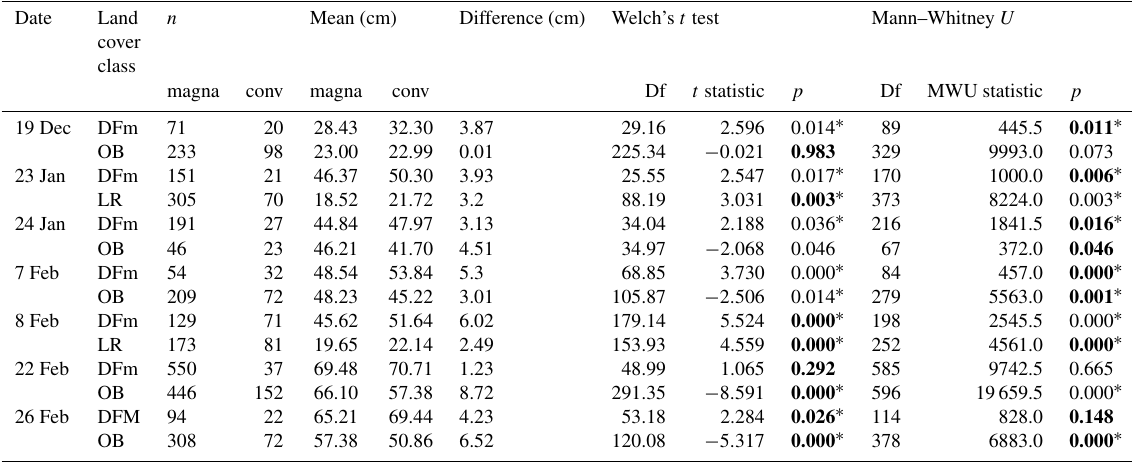
Table 5. The statistical difference of mean snow depth (cm) between the Magnaprobe and the sparse conventional measurements within DFm, OB, and LR. The number of measurements within a group ( n ), the mean snow depth, the difference in the mean measured snow depths, degrees of freedom (Df), test statistic ( t /MWU), and the p value are presented. The p value is marked with ∗ if the result is statistically significant at 0.05. The test type considered more appropriate for each individual group, based on the distribution and variance of the data, is marked in bold.